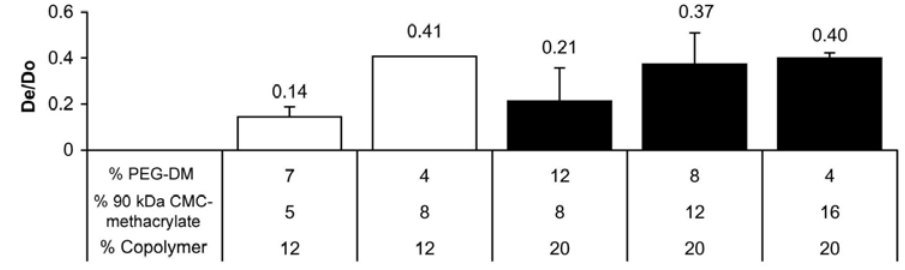
Figure 4. BSA release rates were determined in order to calculate the effective diffusion coefficient, D , for each gel type. D was normalized by the diffusion coefficient of BSA in e e water at 37 °C (D ), 9.14 × 10 − 7 cm 2 /s [14]. Differences are significant between 5:7% o CMC-methacrylate:% PEG-DM and 8:4, 12:8 or 16:4 gels (n =